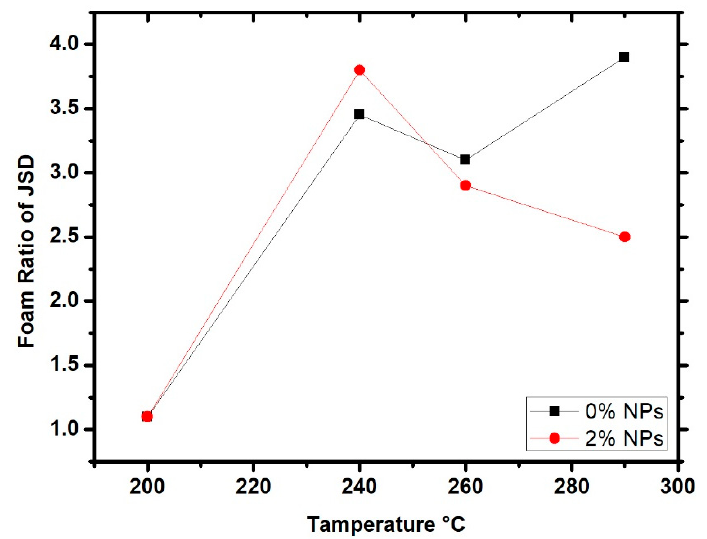
Figure 8. Foam ratios as a function of temperature for pure JSD and JSD + 2% NPs.